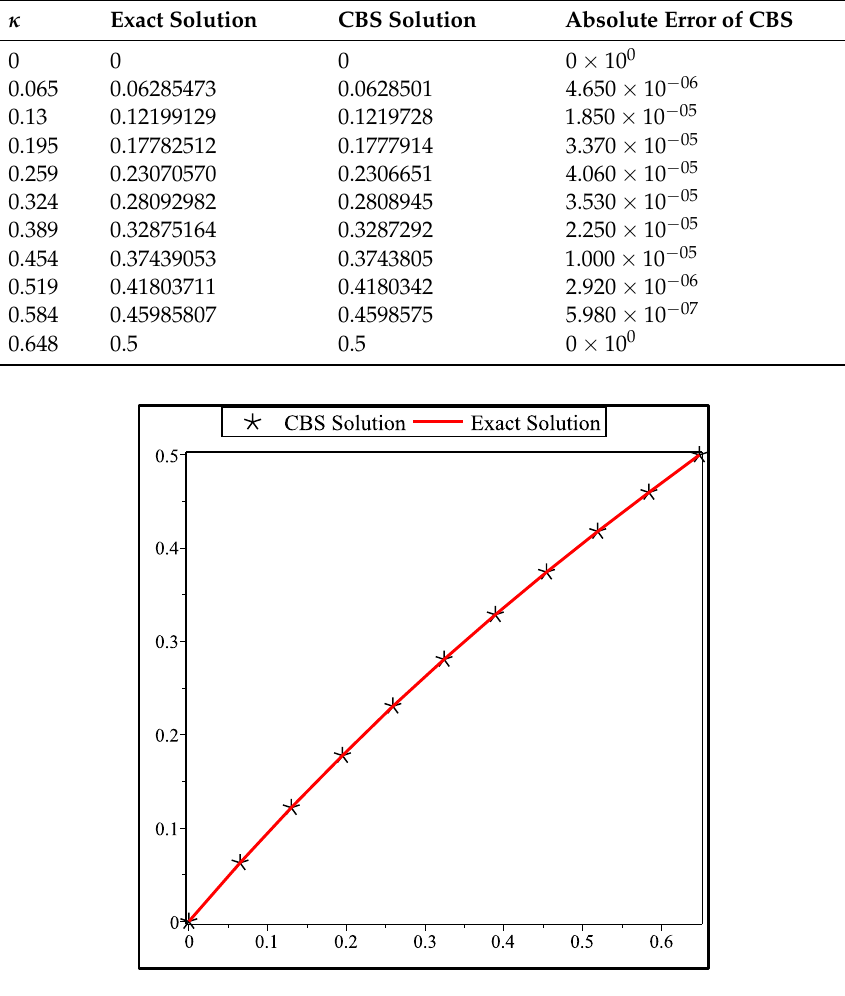
Figure 4. Problem 1 at h = 0.064872